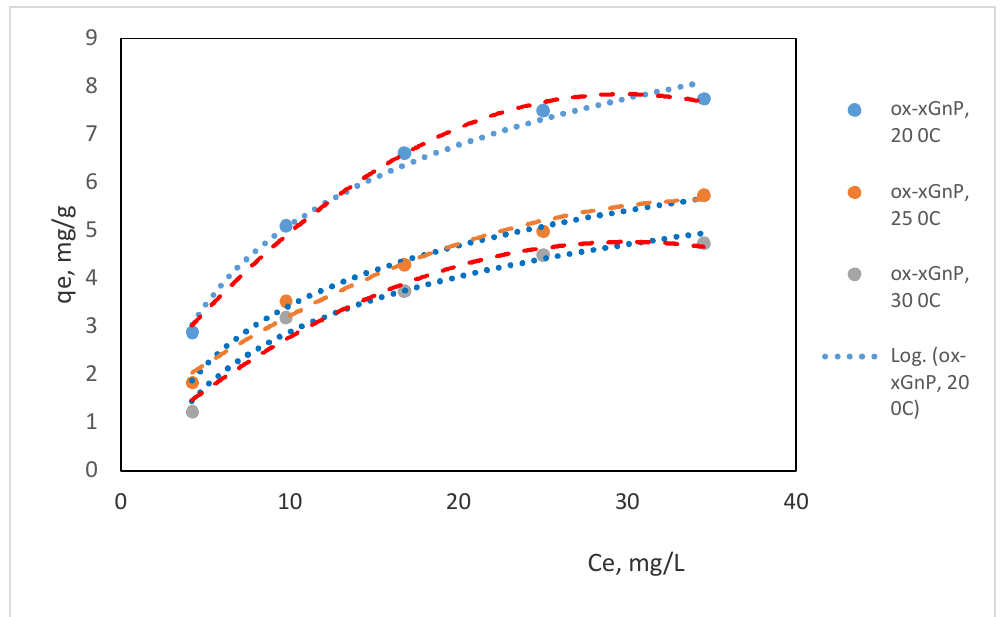
Figure 8. Isotherm models fitting for ammonium adsorption by oxidized xGnP treated with 65 % HNO 3 , three hours reflux time; … Freundlich model, ---Langmuir model and •experimental data at the three temperatures 20, 25 and 30 °C.